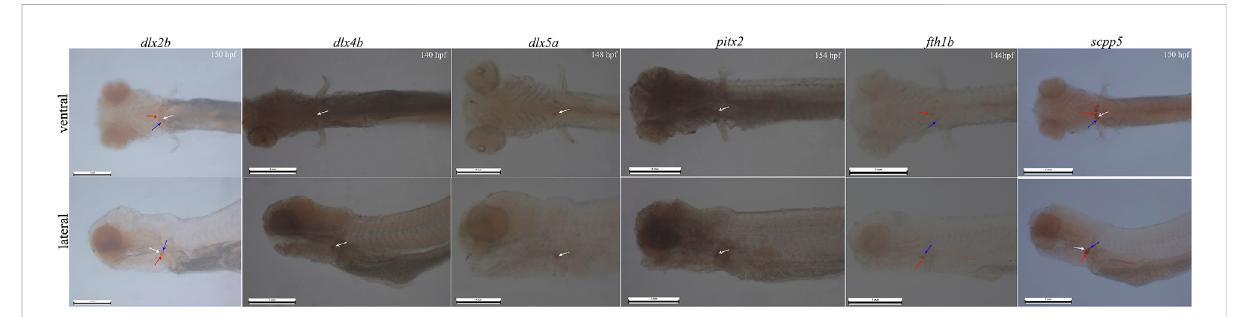
FIGURE 2 Whole-mount in situ hybridization for six genes ( dlx2b , dlx4b , dlx5a , pitx2, fth1b , and scpp5 ) in BT. Pharyngeal region. Anterior is to the left. Ventral (upper) and lateral (lower) views showing tooth location during 140 – 154 h post-fertilization (hpf) prelarval hybridized for the six genes. The 140 – 154 hpfwasdeterminedbythepreviousinvestigation ontheexpressionofthegene scpp5 occurredin4V 1 ,3V 1 ,and5V 1 .Thewhite arrowrefers to 4V, the red arrow refers to 3V, and the blue arrow refers to 5V. 4V 1 , 3V 1 , and 5V 1 strongly express dlx2b and scpp5 , while only 4V 1 weakly expresses dlx4b and pitx2 ; dlx5a is only expressed in the early developing 4V 1 , and fth1b is expressed in the early developing 3V 1 and 5V 1 . Scale bar = 1